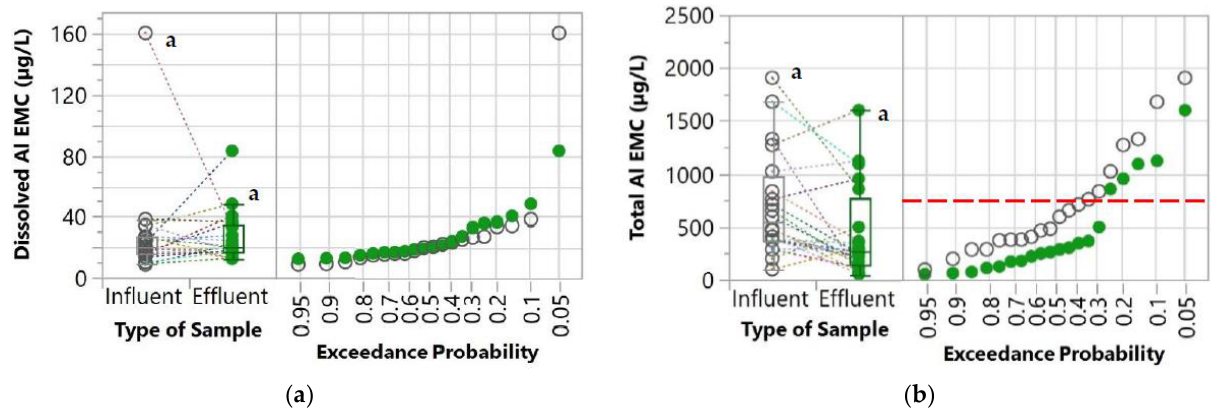
Figure 6. Box plot and normal probability plot of ( a ) dissolved and ( b ) total Al EMCs of both influent and effluent. A pair of influent and effluent EMCs from the same storm event and catch basin are connected with dotted lines. Different lowercase letters (a and b) indicate significant differences between influent and effluent ( p < 0.05) samples. The red horizontal dashed line represents water quality goals [34].